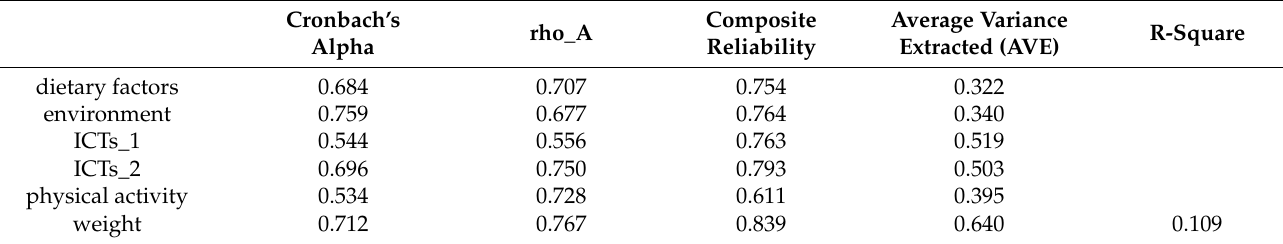
Table 1. Reliability measures and constructs validity.